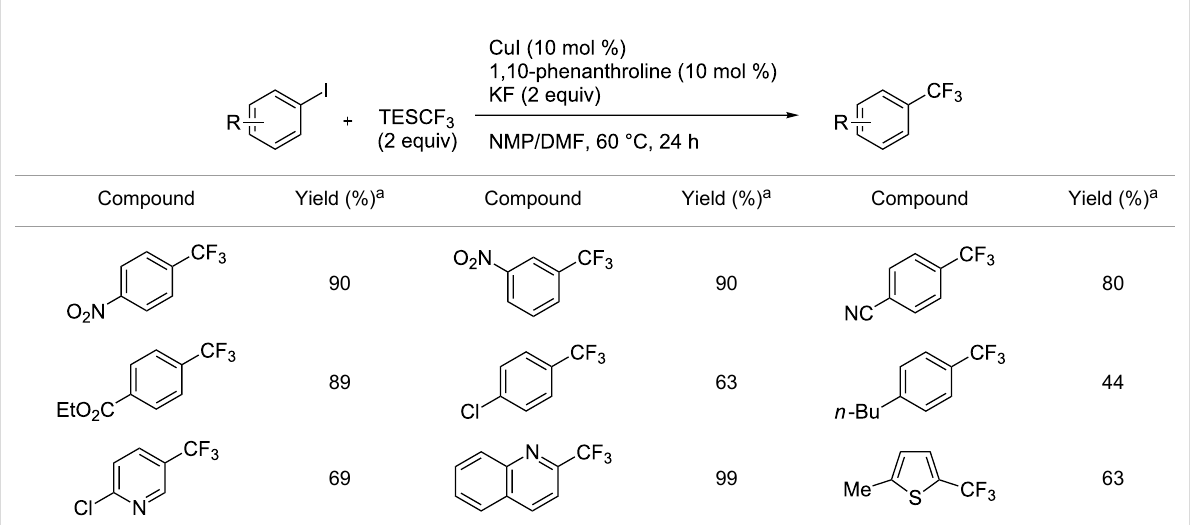
Table 11: The first Cu-catalyzed trifluoromethylation of aryl iodides [33].